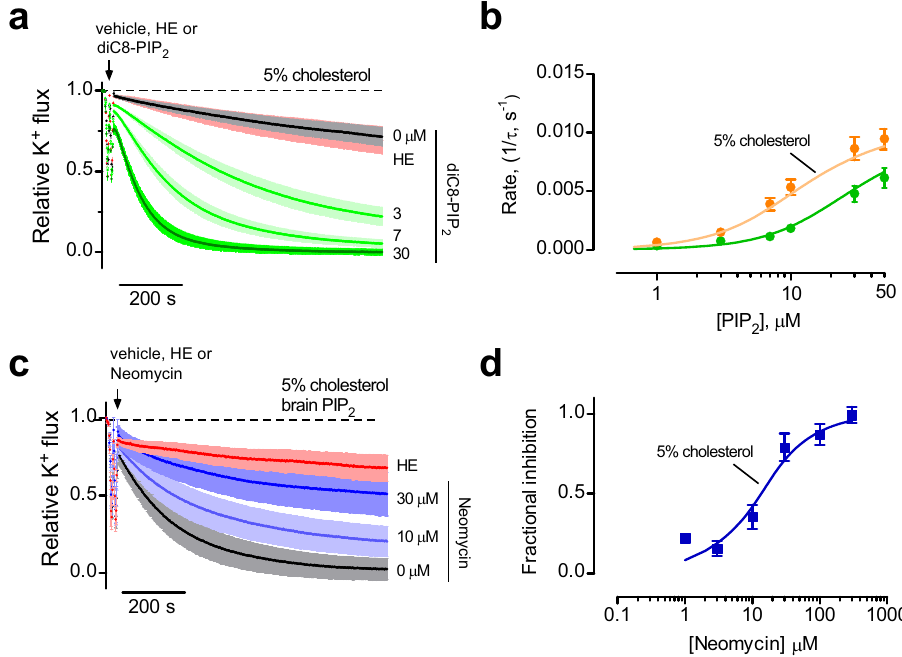
Figure 5. Cholesterol enhances sensitivity of GIRK2 channels to PIP 2 . ( a ) Normalized fluorescent traces (mean ± SEM) show K + flux for GIRK2-containing liposomes with 5% cholesterol in response to increasing concentrations of diC 8 -PIP 2 (green) or MTS-HE (100 μ M, red). Note little change in K + flux in the absence of PIP 2 (black) similar to that of liposomes without cholesterol (n = 7). (b) The rate of K + flux is plotted as a function of different diC 8 -PIP 2 concentrations for GIRK2 in the presence of 5% cholesterol (mustard circles). Line shows best fit using the Hill equation with EC 50 of 12.2 ± 2.5 μ M and a Hill coefficient of 1.5 ± 0.2 (n = 6). For reference, dose-response without cholesterol from Fig. 2B is shown (green circles). (c) Normalized fluorescent traces (mean ± SEM) show K + flux for GIRK2-containing liposomes with 1% brain PIP 2 / 5% cholesterol with different concentrations of neomycin (n = 5). (d) The rate of K + flux for GIRK2/brain PIP 2 /5% cholesterol is plotted as a function of different neomycin concentrations. Line shows best fit using the Hill equation with an IC 50 15.0 ± 4.6 μ M and Hill coefficient of 1.2 ± 0.3 (n =